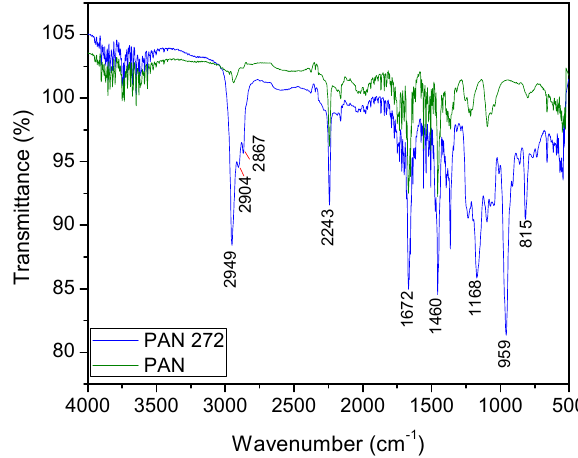
Figure 3. ATR-FTIR spectra of PAN and PAN-272 nanofiber membranes.